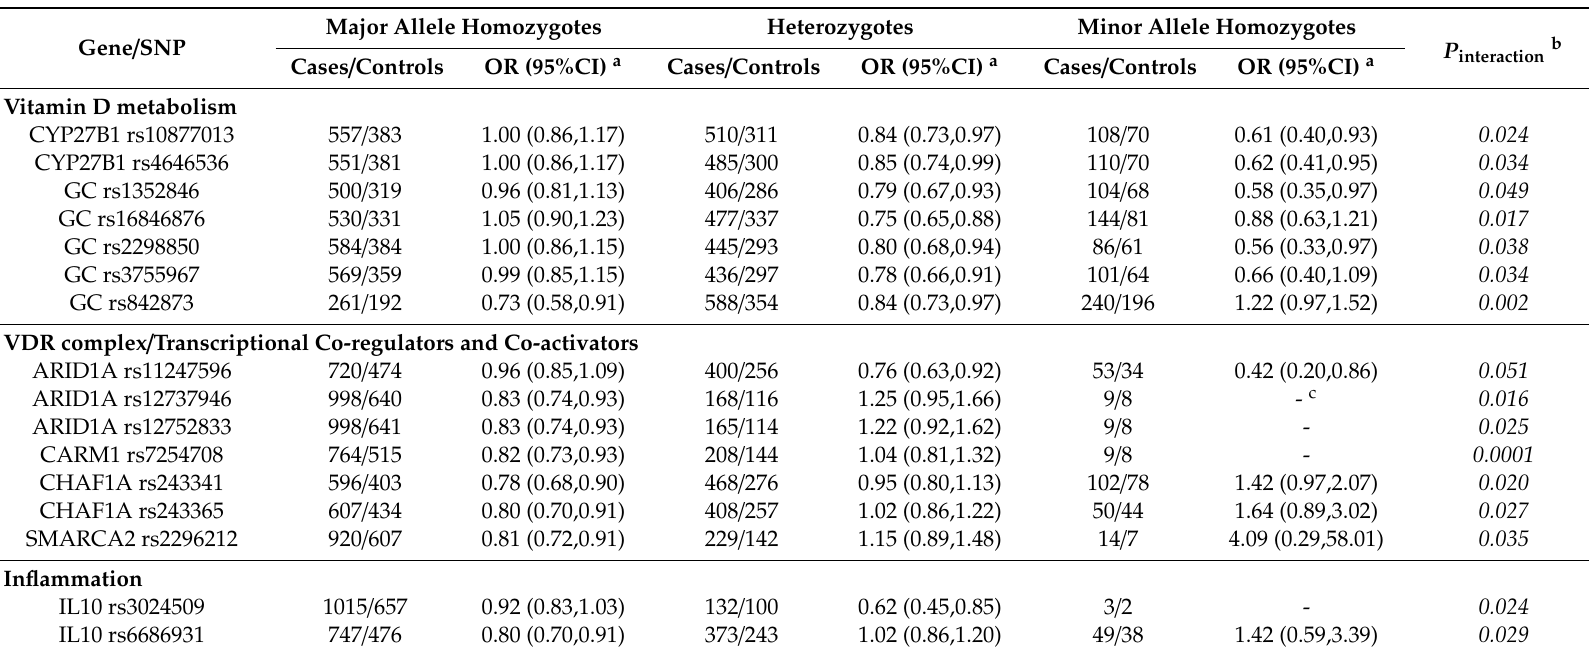
Table 5. Associations of season-adjusted 25(OH)D concentrations (per 24.96 nmol / L) with CRC risk by genotypes, the EPIC study, 1992–2003. Major Allele Gene / SNP